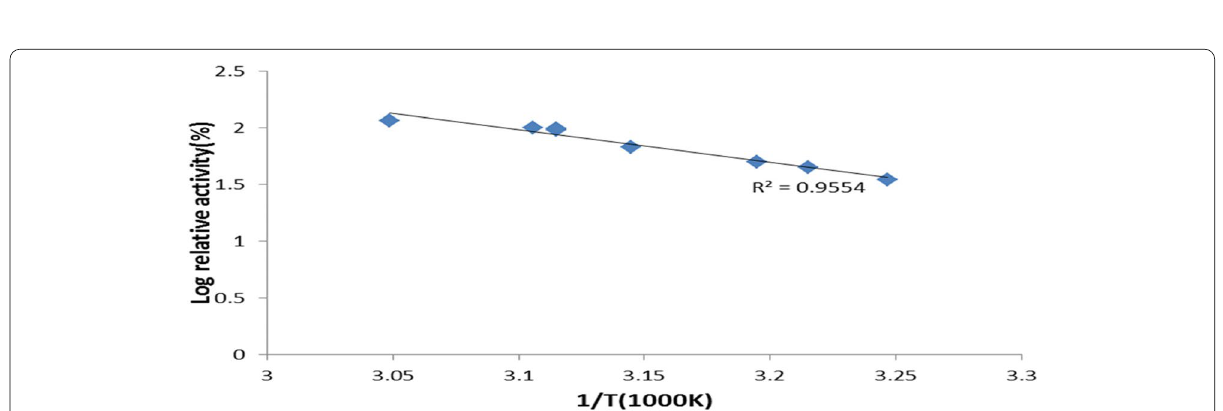
Fig. 9 Arrhenius plots to calculate activation energy (Ea) for A. terreus xylanase